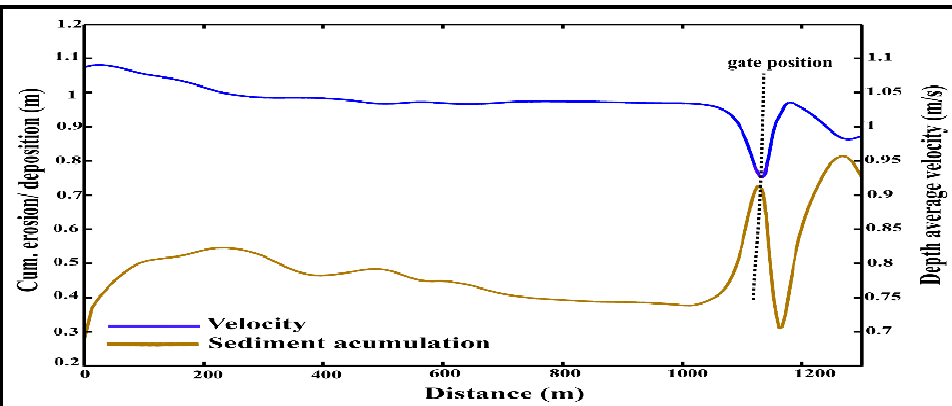
Figure 9. Relationship between velocity and the accumulated sediment in the main canal.